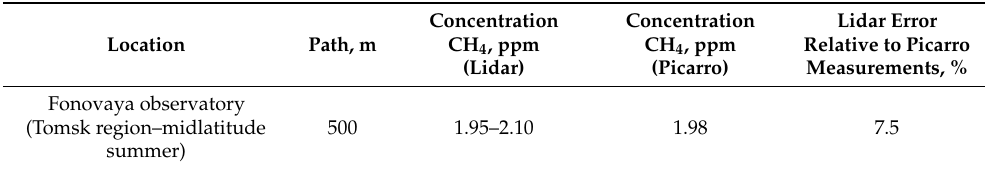
Table 4. Results of lidar measurements at Tomsk region and comparison with the results of in situ measurements of Picarro gas